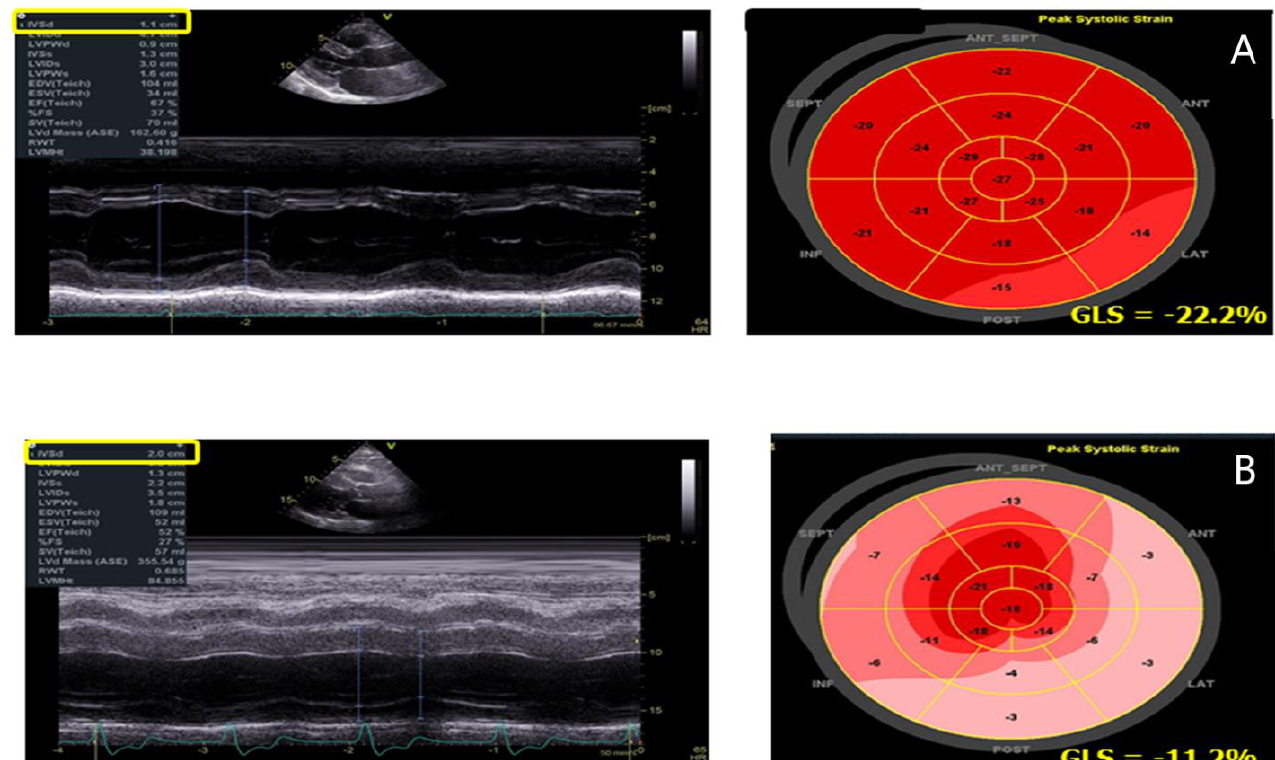
Figure 4. AFD patient with initial septal hypertrophy and reduction in the infero-lateral regions’ strain ( A ); AFD patient with advanced hypertrophy and strain reduction inall basal segments of the left ventricle ( B ).